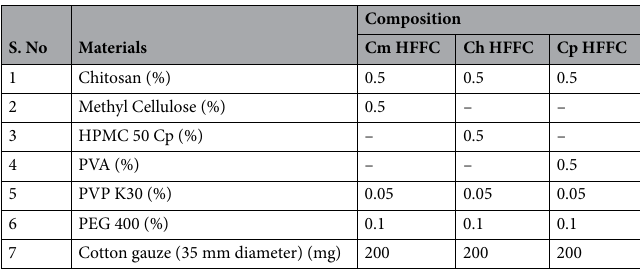
Table 1. Continuous phase composition of